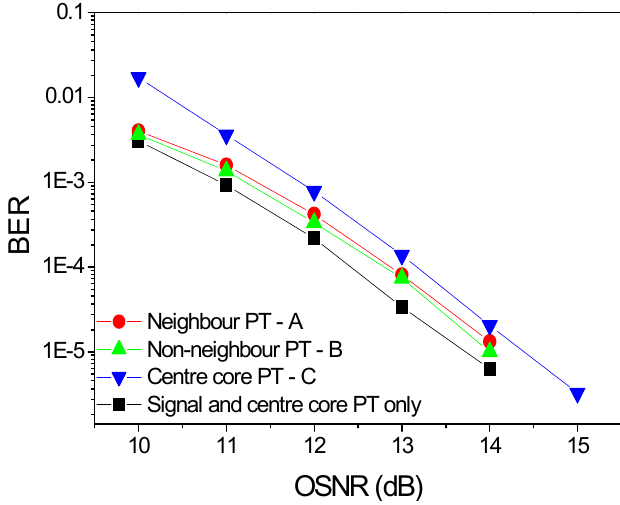
Figure 7. Measurement of SDM penalties when transmitting the pilot-tone on different fiber cores compared to SHD transmission without dummy channels. OSNR, optical signal-to-noise ratio.